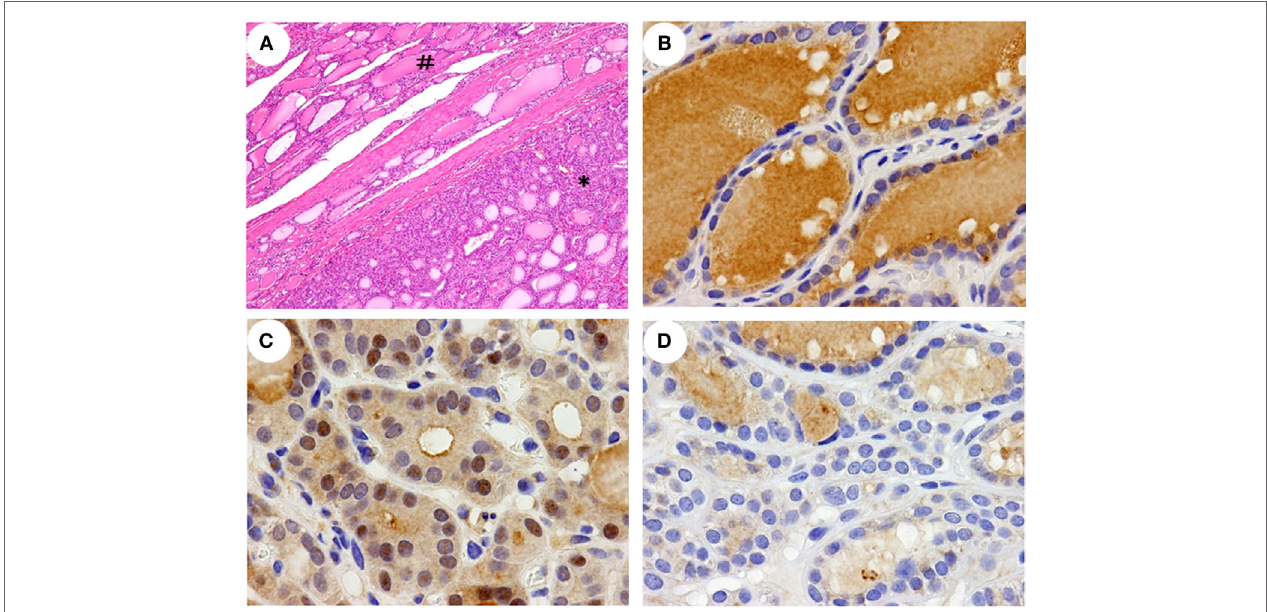
FIGURe 2 | Histopathological features and immunohistochemical detection of NRF2 in the thyroid . A histopathological feature (a) of a left lobe shows non-nodular parenchyma (#) and a partially encapsulated follicular nodule (*). A greater nuclear accumulation of NRF2 was detected in a nodular lesion of the patient (C) than in a non-nodular parenchyma of the patient (B) and a nodular lesion in a control (D) . The data shown are representative of two experiments with similar results. Original magnification; 40 × ( a ), 400 × (B–D)